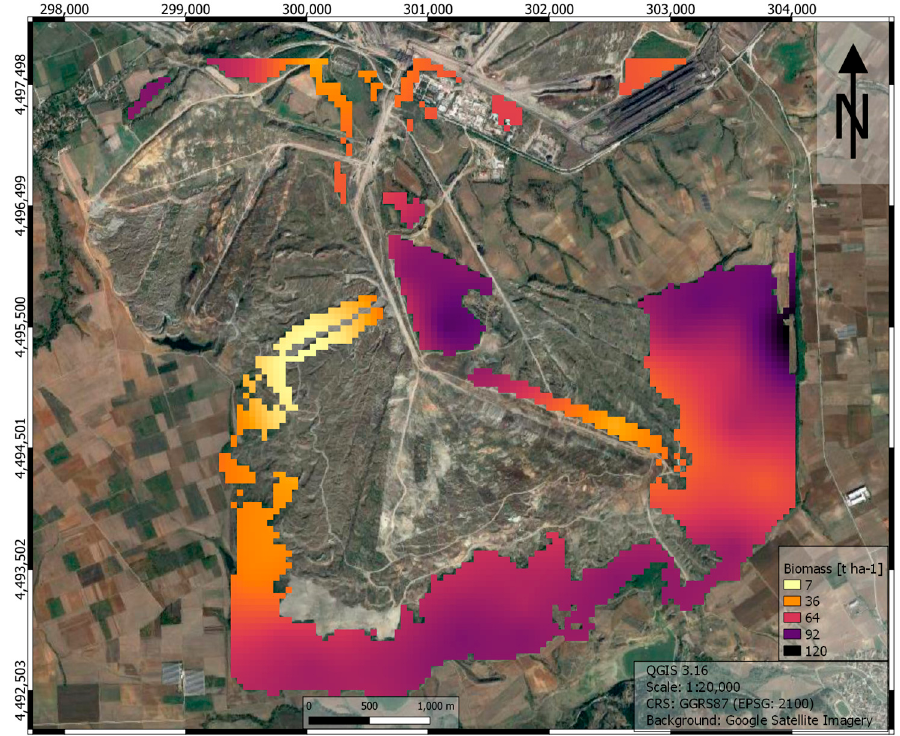
Figure 4. Aboveground biomass distribution map at Amyntaio mining area. Coordinates in the Hellenic Geodetic Reference System (HGSA 87).